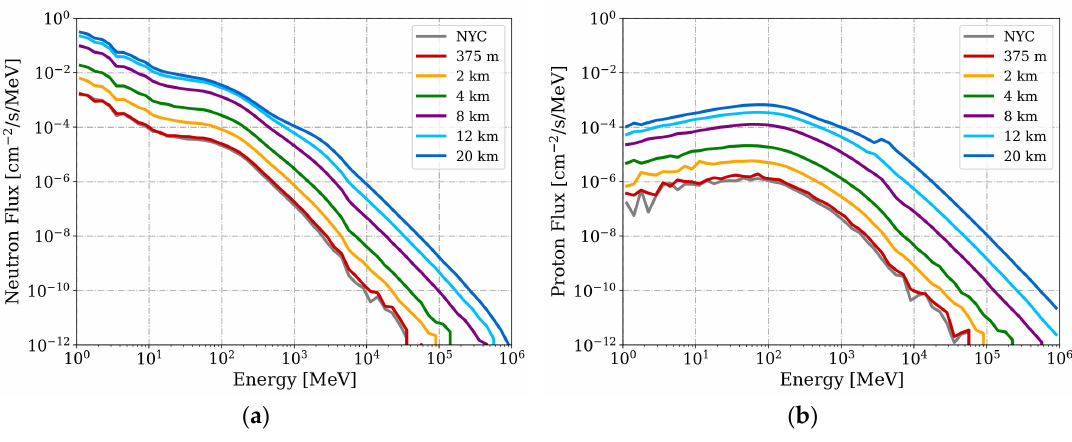
Figure 1. Differential spectra of neutrons ( a ) and protons ( b ) above 1 MeV at different altitudes over Geneva in Switzerland and 1 m above sea level in New York City (NYC). Simulations retrieved through the Model for Atmospheric Ionizing Radiation Effects (MAIRE).